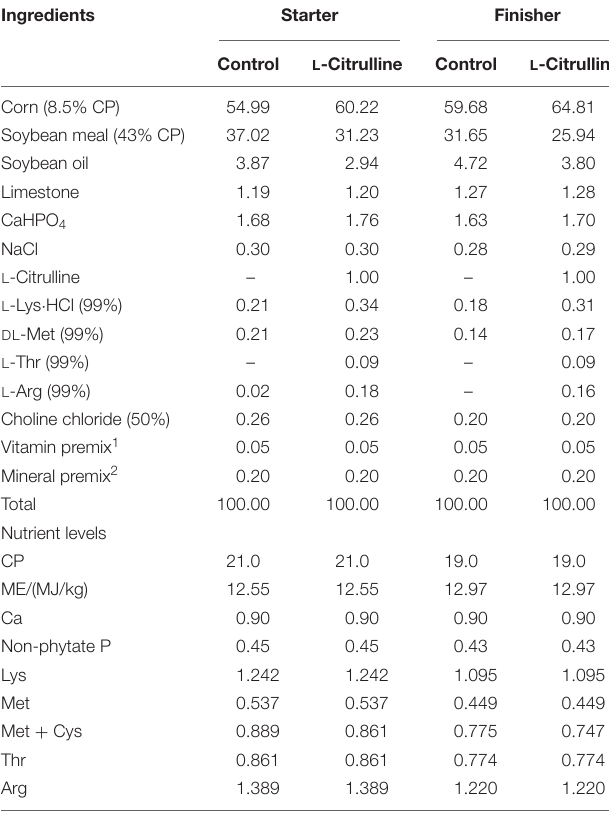
TABLE 1 | Composition and nutrient levels of basal diets (as-fed basis) %.